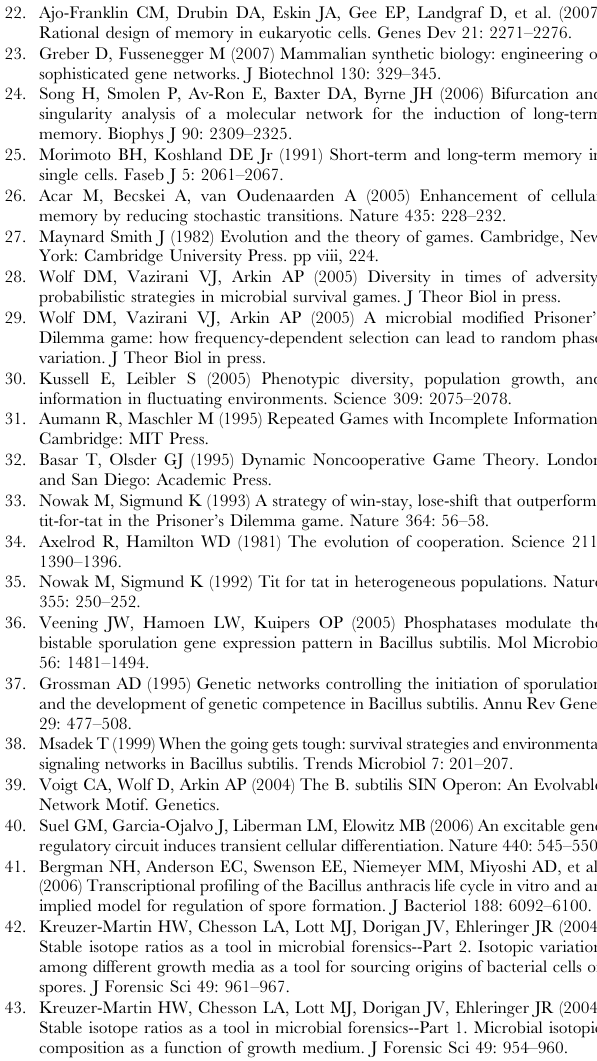
Table S2 Bacillus strain and plasmid table.